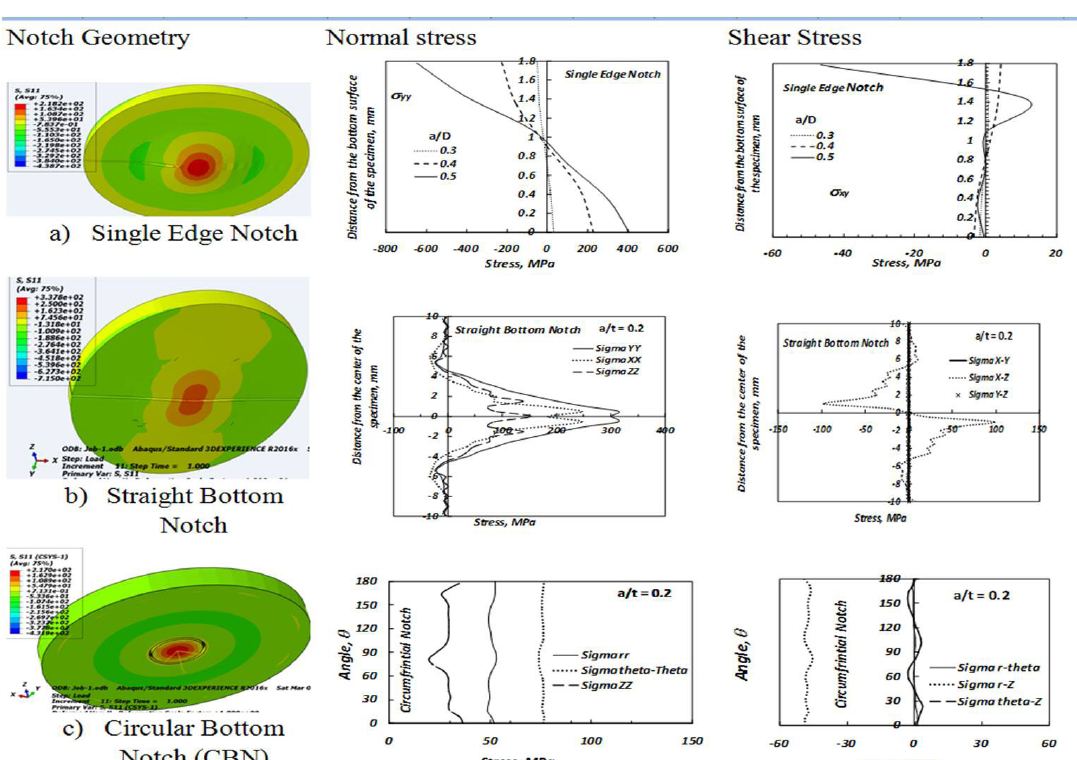
Figure 18. The stress distribution around the crack front of three different crack